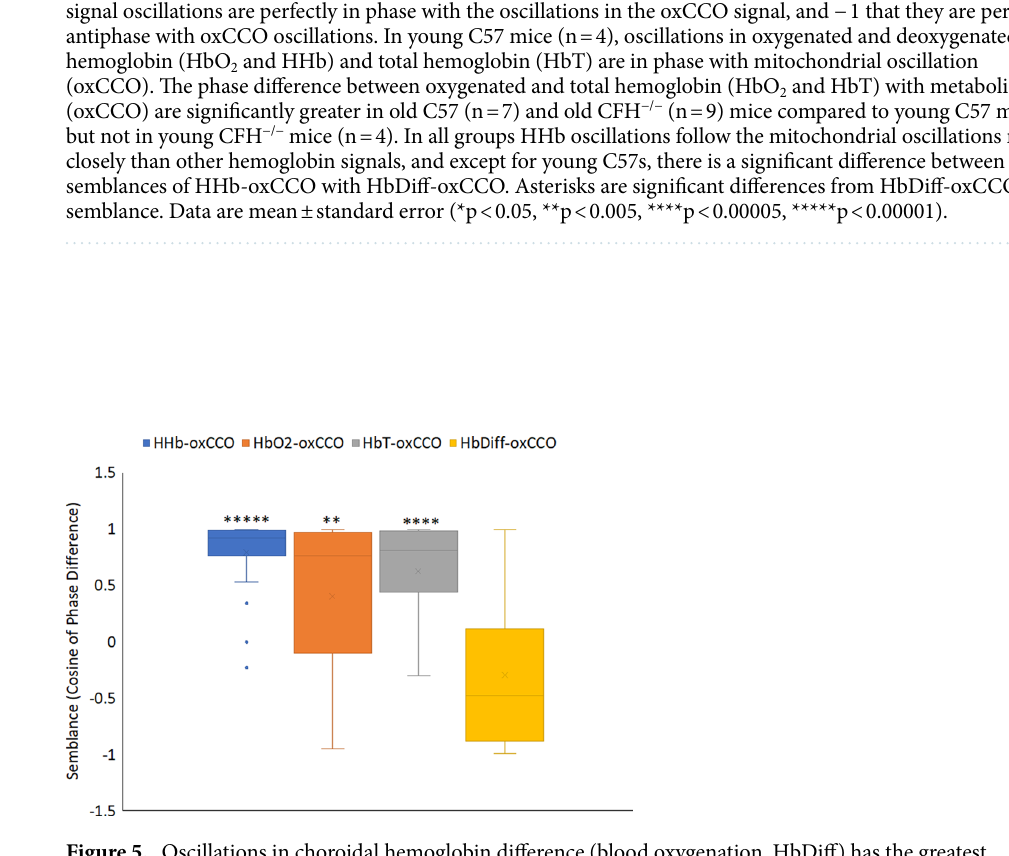
Figure 5. Oscillations in choroidal hemoglobin difference (blood oxygenation, HbDiff) has the greatest dissociation (smallest semblance) with oscillations in retinal Metabolism. Oscillatory phase differences (wavelet semblance) between hemoglobin (HHb, HbO 2 , HbT and HbDiff) and oxCCO signals in all the mice (n = 24) averaged over 1 h. The mean semblance for each animal is calculated at the specific slow-wave oscillation frequency for that animal (the most predominant peak on the FFT signal. Here, there is a significantly greater phase difference between mitochondrial metabolism (oxCCO) with hemoglobin oxygenation (HbDiff) corresponding to oxygen delivery. Semblance of + 1 implies that hemoglobin signal oscillations are in perfect phase with oscillations in the oxCCO signal. Semblance of − 1 implies that they are perfectly anticorrelated. The semblance of HHb, HbO 2 and HbT with oxCCO signals in all the mice are significantly greater than the semblance of HbDiff-oxCCO as compared using Wilcoxon Rank sum test. Data are mean ± standard error and the statistical significance is for each group against the right hand boxplot (HbDiff-oxCCO semblance) (**p < 0.005, ****p < 0.00005, *****p <